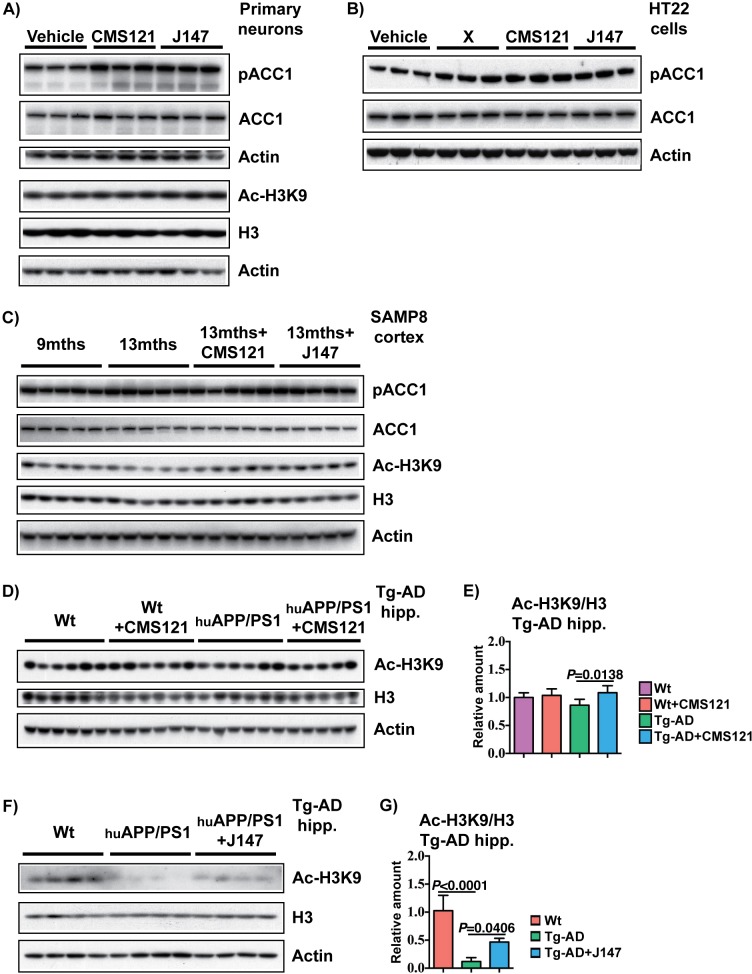
Phosphorylation of ACC1 and acetylation of H3 in primary neuronal cultures, HT22 cells and brain cortex of SAMP8 mice by CMS121 and J147.RIPA-soluble fractions from 7 DIV rat primary neurons (A) and HT22 cells (B) treated with 1 μM of each compound for 4 hr, cortical tissue of 9 months, 13 months, 13 months+CMS121 and 13 months+J147 SAMP8 mice (C), cortical tissue of 18 months Wt, Wt+CMS121, APPswe/PSEN1dE9 and APPswe/PSEN1dE9+CMS121 mice (D and E) and cortical tissue of 23 months Wt, APPswe/PSEN1dE9 and APPswe/PSEN1dE9+J147 (F and G) were analyzed by Western blotting for ACC1 phosphorylated at serine 79 (pACC1), total ACC1, acetylated histone H3 at Lys 9 (Ac-H3K9), total histone H3 and actin. Samples from Tg-AD mice treated with CMS121 and J147 are from two separate studies. Quantifications represented are Ac-H3K9 normalized to total H3. All data are mean ± SD. One-way ANOVA followed by Tukey-Kramer post-hoc test (n = 3/group for rat primary neurons and HT22 cells, n = 5/group for SAMP8, n = 5–6/group for APPswe/PSEN1dE9 CMS121 study, n = 4/group for APPswe/PSEN1dE9 J147 study).